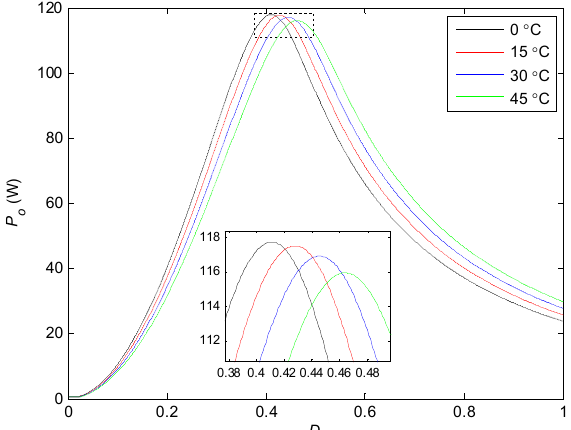
Figure 3. P o − D curves under different temperature conditions.